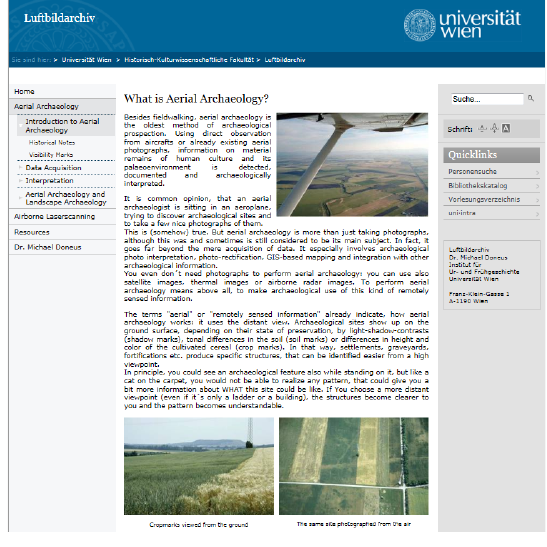
Figure 2: Introduction to aerial archaeology http://luftbildarchiv.univie.ac.at/aerial-archaeology/introduction-to- aerial-archaeology/